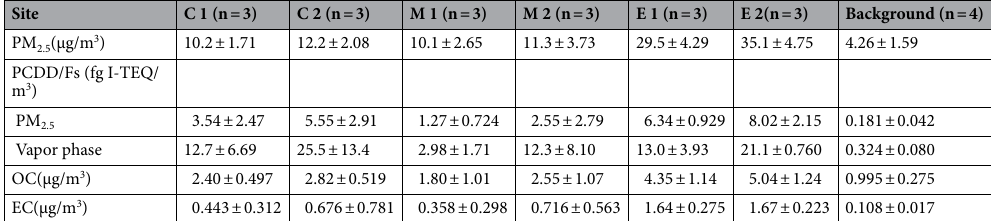
Site C 1 (n = 3) C 2 (n = 3) M 1 (n = 3) M 2 (n = 3) E 1 (n =